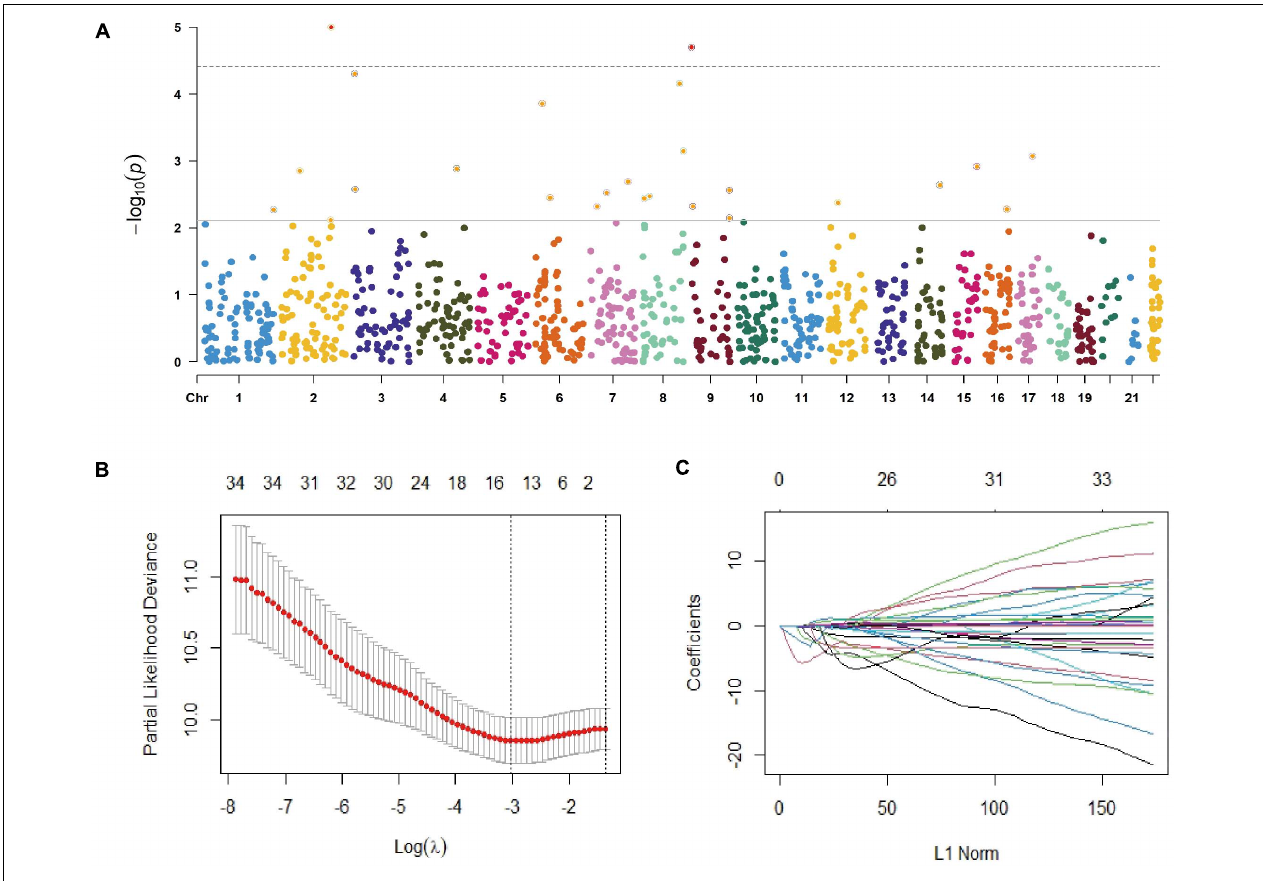
FIGURE 1 | Selection of gCNVs with potentially prognostic value on OS of NSCLC. (A) Scatter plot of P values in –log10 scale from the univariate Cox model analysis on association between the genome-wide gCNVs and NSCLC OS in the TCGA NSCLC patients. (B,C) Selection of predictive gCNVs using the Lasso regression model. Tuning parameter ( λ ) selection in the Lasso model via minimum criteria (B) and Lasso coefficient profiles of the 35 OS-related gCNVs (C) .